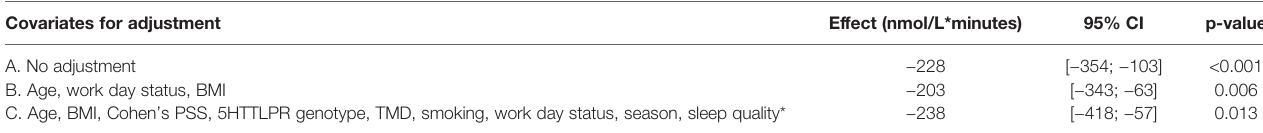
TABLE 2 | The effect of OC-use on CAR evaluated in generalized least square analyses in alternative models with increasing complexity. Covariates for